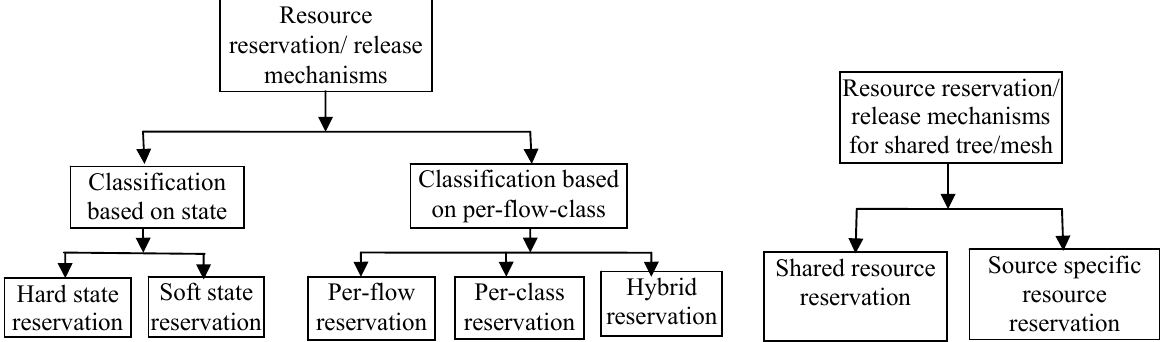
Figure 1. (a, left) Classification of resource reservation/release mechanisms of QoS enable multicast protocols right) Classification of resource reservation/release mechanisms for shared